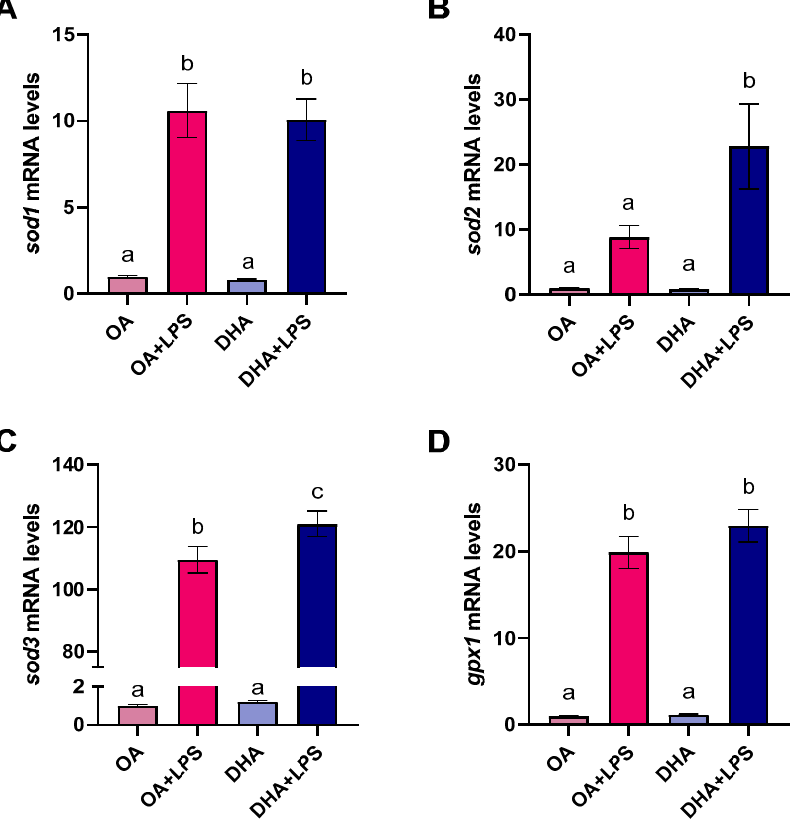
Figure 7. Transcript levels of superoxide dismutase 1 (cytosolic) ( sod1 ) ( A ), superoxide dismutase 2 (mitochondrial) ( sod2 ) ( B ), superoxide dismutase 3 (extracellular) ( sod3 ) ( C ), and glutathione peroxidase 1 ( gpx1 ) ( D ) in mature adipocytes incubated for 6 days with 100 µ M oleic acid (OA) or 100 µ M docosahexaenoic acid (DHA) and thereafter exposed to lipopolysaccharide (LPS) for 20 h (OA + LPS and DHA + LPS, respectively). Samples ( n = 8 for OA and DHA groups and n = 6 for OA + LPS and DHA + LPS) were analyzed with real-time qPCR. Data are presented as fold change ± SEM using ef1 α as a reference gene and the OA group was set to one (delta-delta method). Di ff erent letters indicate significant di ff erences between treatments ( p < 0.05, ANOVA followed by Tukey’s post hoc